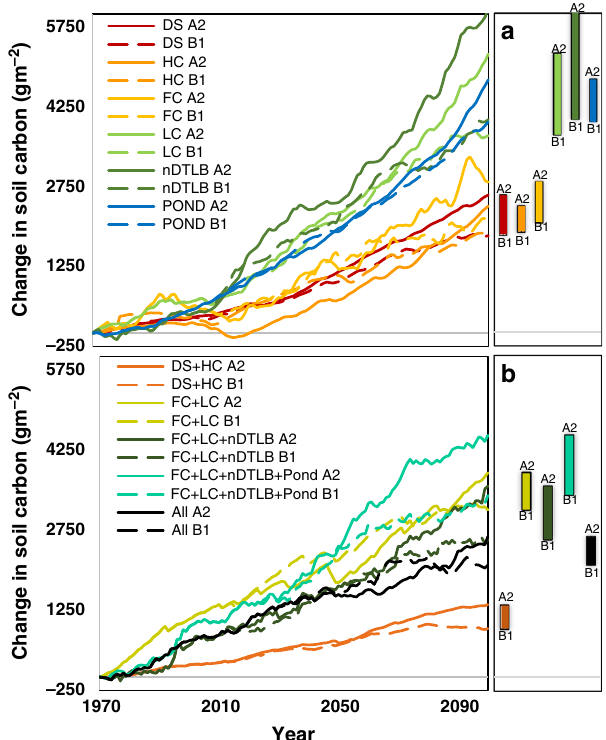
Fig. 4 Projected change in soil carbon pools through 2100. Simulated change in soil carbon among all polygonal tundra landforms ( a ; DS drained slope, HC high center, FC fl at center, LC low center LC, nDTLB nonpatterned drained thaw lake basins) and landform groups ( b ) forced using CCCMA A2 and ECHAM5 B1 climate and emission pathways for our study region. Climate forcing for CCCMA A2 and ECHAM5 B1 are comparable to RCPs 6.0 and 4.5, respectively. Cluster analysis using key hydrologic and biogeochemical characteristics facilitated in the grouping of data for model re- parameterization and re-calibration of landform groups ( b